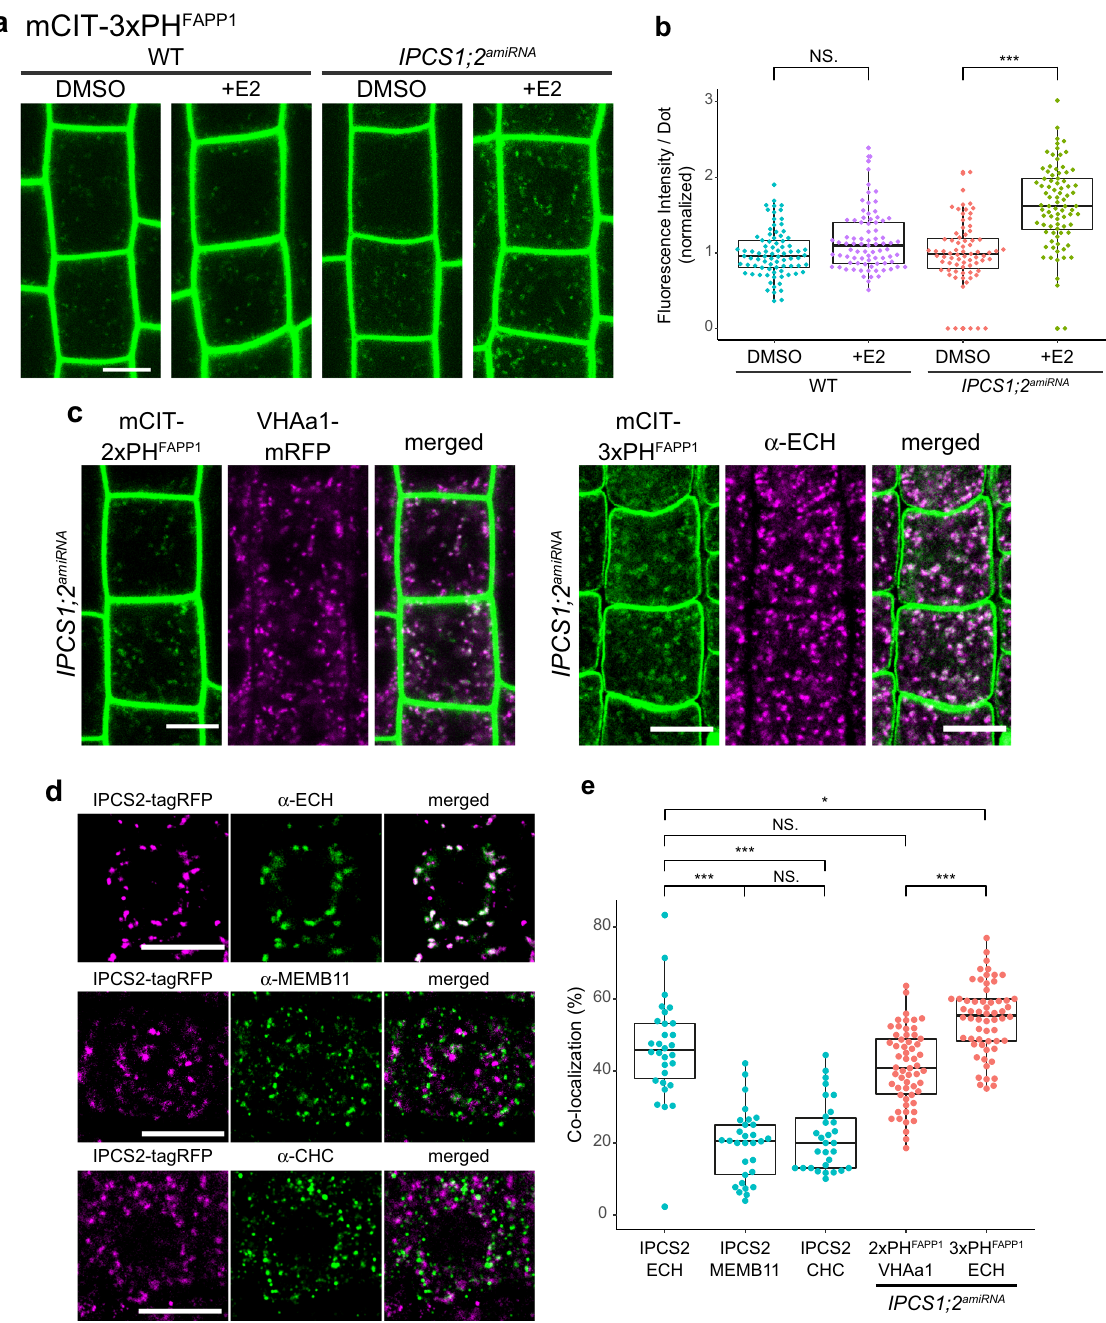
Fig. 7 IPCS enzymes are involved in PI4P distribution at SVs subdomain of TGN where they localize. a Confocal micrographs of Arabidopsis root epidermal cells expressing the PI4P biosensor mCIT-3×PH FAPP1 in wild-type seedlings or IPCS1;2 amiRNA line in control condition (DMSO) or treated with the β -estradiol inducer (E2). b Fluorescence intensity at intracellular dots was quanti fi ed. The IPCS1;2 amiRNA line induced by β -estradiol accumulates PI4P in intracellular dots. n = 81 cells from 27 roots (WT + DMSO, WT + E2), 75 cells from 25 roots ( IPCS1;2 amiRNA + DMSO), 84 cells from 28 roots ( IPCS1;2 amiRNA + E2). c Colocalization between PI4P biosensors mCIT-2×PH FAPP1 or mCIT-3×PH FAPP1 and the SVs/TGN marker VHA-a1-mRFP or ECHIDNA protein, respectively, in the IPCS1;2 amiRNA line induced by β -estradiol. d Colocalization between IPCS2-tagRFP and the SVs/TGN marker ECHIDNA, the CCVs/TGN marker CHC, or the Golgi marker MEMBRIN11. e Colocalization quanti fi cation of c and d . IPCS2 strongly co-localizes with SVs/ TGN and more weakly with CCVs/TGN or the Golgi. PI4P biosensors strongly co-localize with SVs/TGN in the IPCS1;2 amiRNA line, to a similar level as the colocalization of IPCS2 with SVs/TGN. n = 30 roots (IPCS2 + ECH, IPCS2 + MEMB11, IPCS2 + CHC), 58 cells from 20 roots (2×PH FAPP1 + VHA-a1), 60 cells from 20 roots (3×PH FAPP1 + ECH). Statistics were done by two-sided Wilcoxson ’ s rank-sum test ( b ) or two-sided Dwass-Steel-Critchlow-Flinger multiple comparison test with Monte Carlo method (10,000 iterations) ( e ), * P < 0.01, *** P < 0.0001. Each element of the boxplot indicates the following value: center line, median; box limits, the fi rst and third quartiles; whiskers, 1.5× interquartile range; points above or below the whiskers, outliers. Scale bars, 10 µ